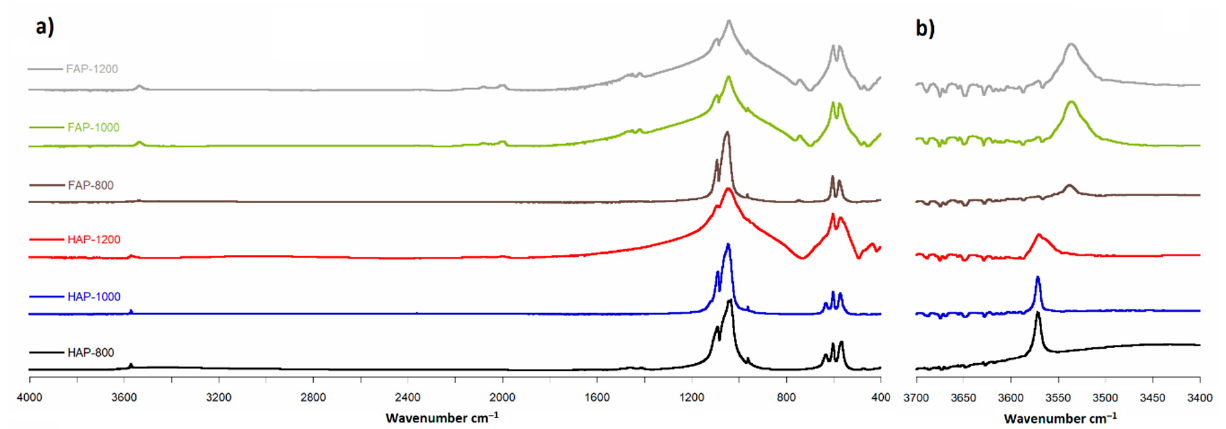
− 1 ; ( b ) range 3400 to 3700 cm − 1 (magnified 10 ×